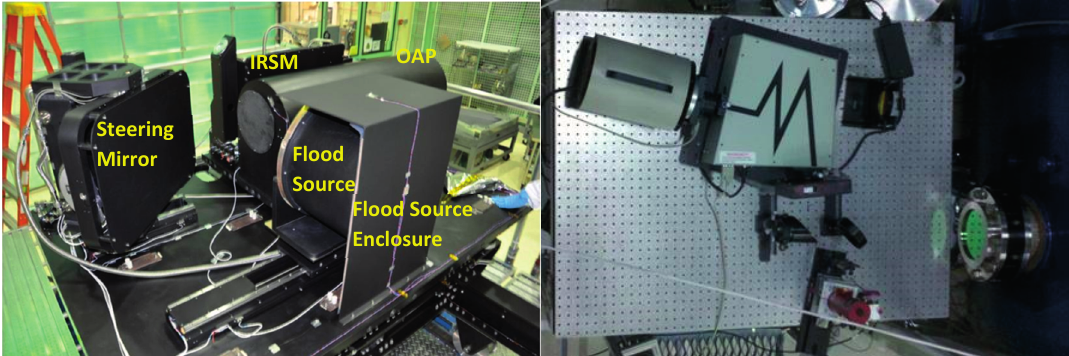
Figure 8. ( Left ) Picture of the TIRS calibration system before it was put into the thermal vacuum test chamber. ( Right ) The grating monochromator system used to verify that the spectral shape of a representative set of pixels was consistent with the product of the component level